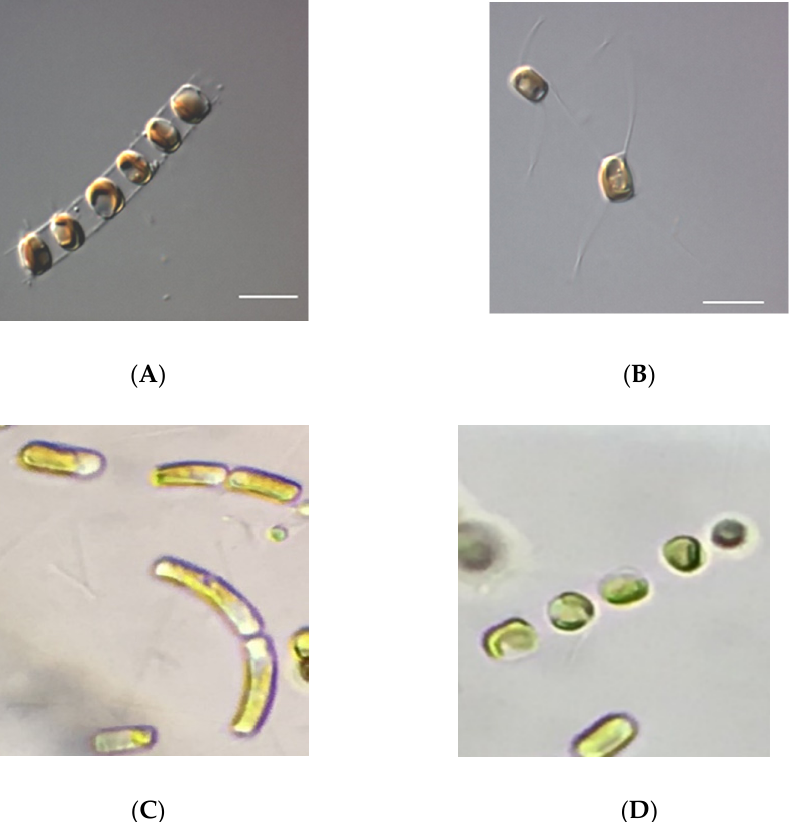
Figure 4. Microscopic observations of diatoms: Skeletonema costatum ( A ), Chaetoceros calcitrans ( B ), and Skeletonema costatum cells growing with a silicate supply of 0.4 mM ( C ), where unhealthy elongated cells were observed, and Skeletonema costatum cells growing with a silicate supply of 2.4 mM ( D ), where the cultures had a healthy morphology. For ( A , B ), the differential interference contrast (DIC) and a 100 × lens with additional 1.6 × amplification via an Optovar module was used. Scale bar = 20 µm.